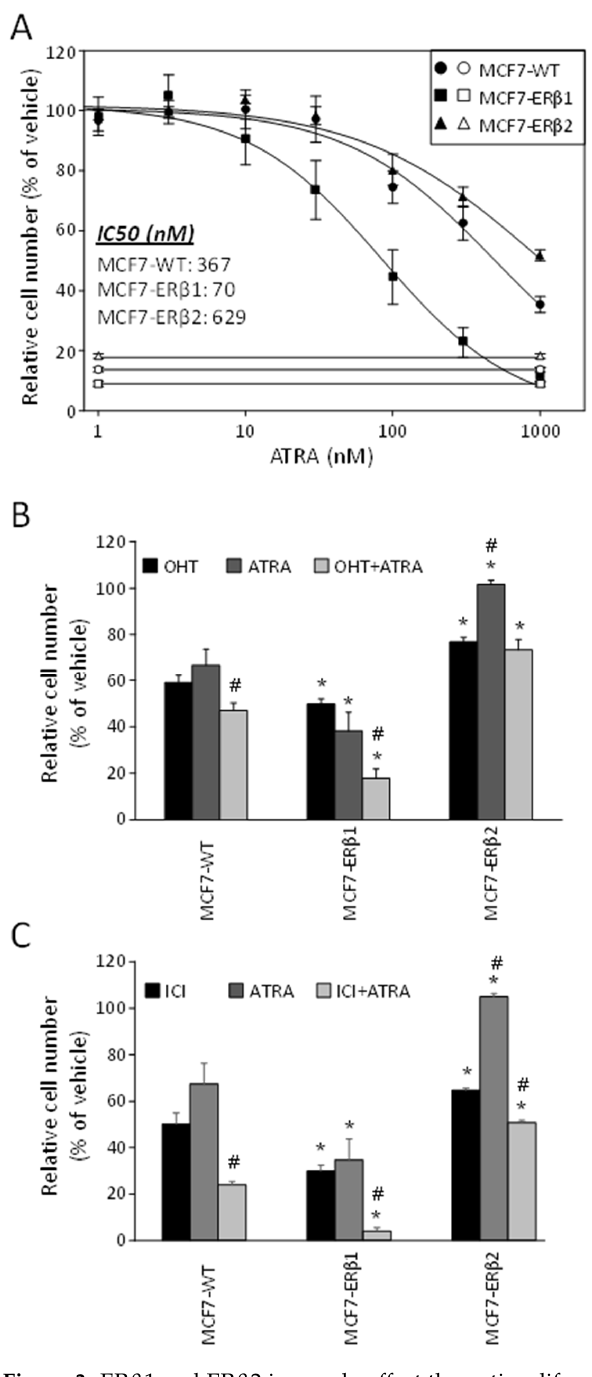
Figure 3. ER β 1 and ER β 2 inversely affect the antiproliferative efficacy of ATRA. ( A ) Proliferation of MCF7-WT, MCF7-ER β 1 and MCF7-ER β 2 cells treated with vehicle (0.1% DMSO) or increasing concentrations of ATRA for six days. Relative cell numbers were expressed as percentage of cell number of vehicle-treated cells. Plots are representative of at least three independent experiments carried out in triplicate. ( B , C ) Proliferation of MCF7-WT, MCF7-ER β 1 and MCF7-ER β 2 cells treated with vehicle (0.1% DMSO), OHT (1 nM), ICI (1 nM), ATRA (100 nM) or their combination, as indicated, for six days. Relative cell numbers were expressed as percentage of cell number in vehicle-treated cells. Values (mean ± SEM) are from at least three independent experiments carried out in triplicate. * p < 0.05 vs. similarly treated MCF7-WT, # p < 0.05 vs. respective OHT- or ICI-treated cell line ( t -test). OHT, 4-hydroxytamoxifen; ATRA, all-trans retinoic acid; ICI,